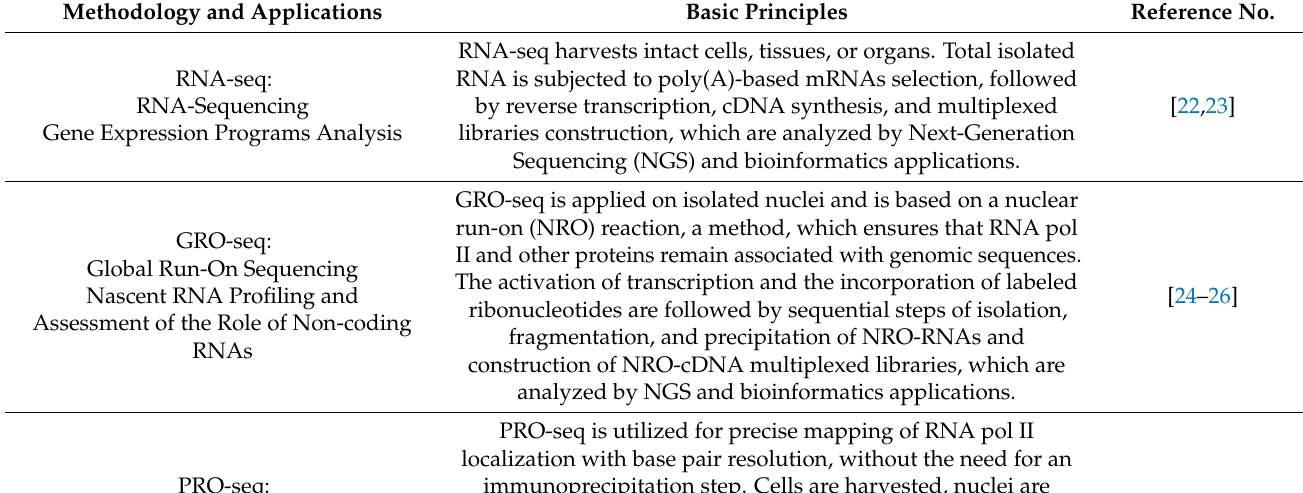
Table 1. A toolbox of advanced methodologies for enhancers’ and Super-enhancers’